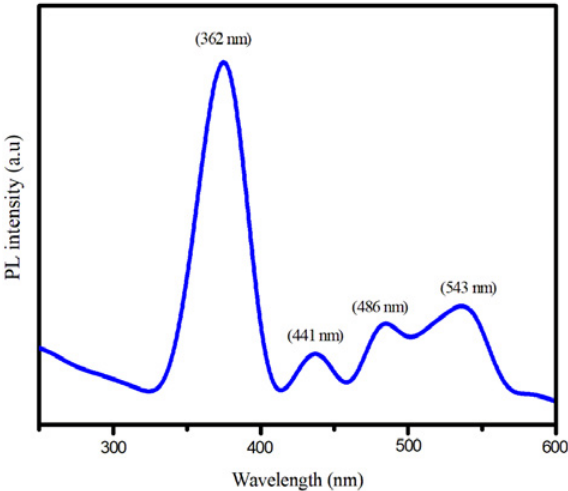
Fig. 7. PL spectra of biosynthesized ZnO